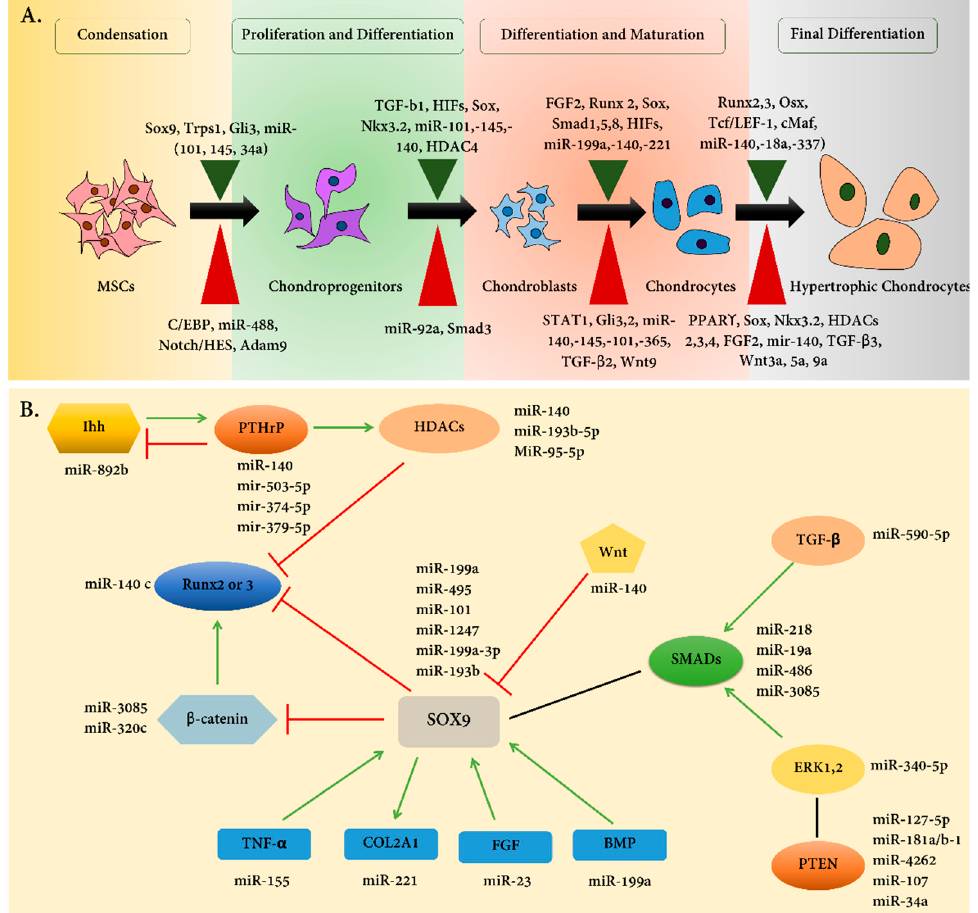
Figure 1. A) Main steps of chondrogenesis and the signaling factors involved in